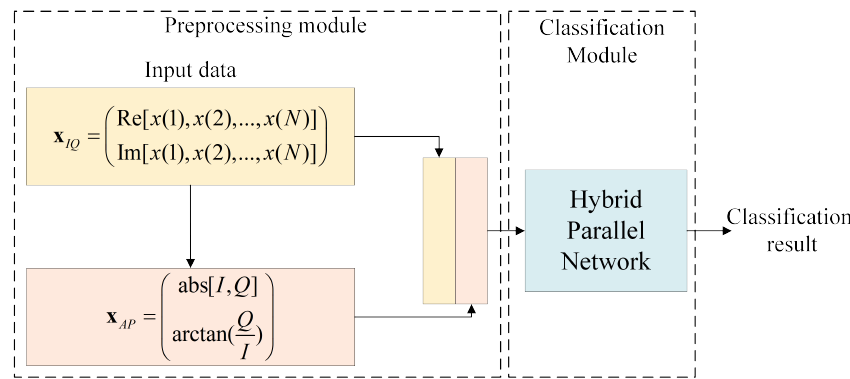
Figure 1. The system model of our proposed